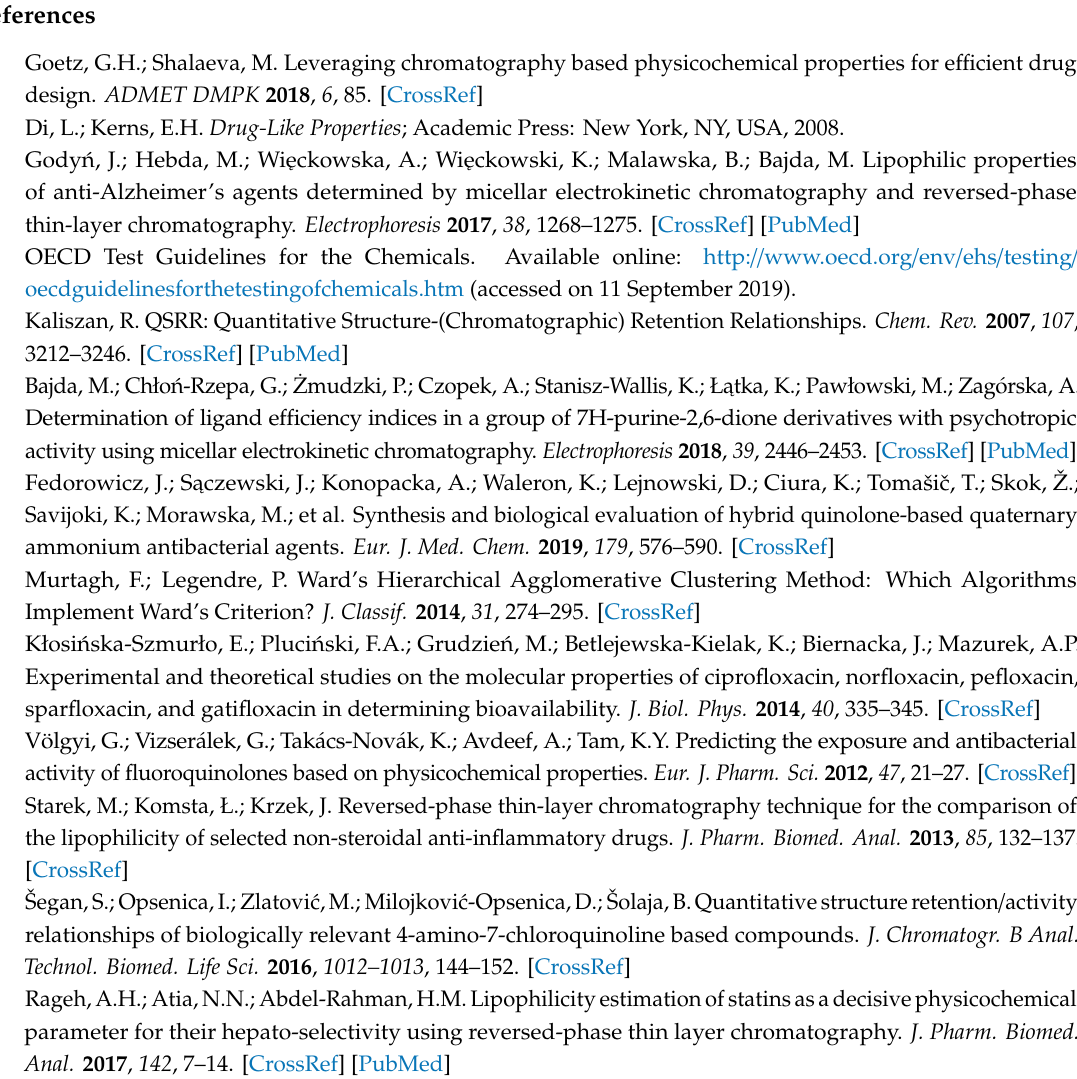
s1. Table S1. Chemical names and structural formulas of the studied compounds. Table S2. Retention parameters R M obtained in RP-TLC systems. Table S3. Statistical parameters of fitted Soczewi´nski–Wachtmeister’s equation for each of the studied compounds. Table S4. Correlation matrix of TLC chromatographic parameters. Figure S1. Ranking of computational methods for lipophilicity estimation. Figure S2. Ranking of chromatographic lipophilicity indexes. Figure S3. Ranking of computational methods for lipophilicity estimation. Figure S4. Ranking of chromatographic lipophilicity